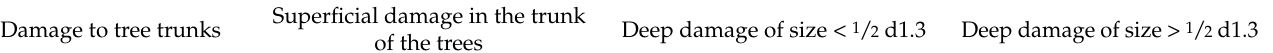
Table 2. Classification of damage to remaining trees. Classification According to Field Parameters Damage Site Mild Severe Irreversible Damage to